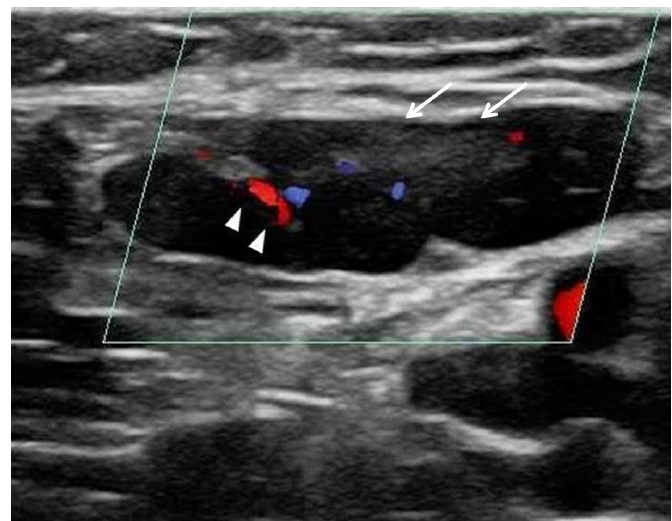
Figure 2. Enlarged inguinal lymph node (arrows) demonstrating flow in the hilar region with Color Doppler (arrowheads).